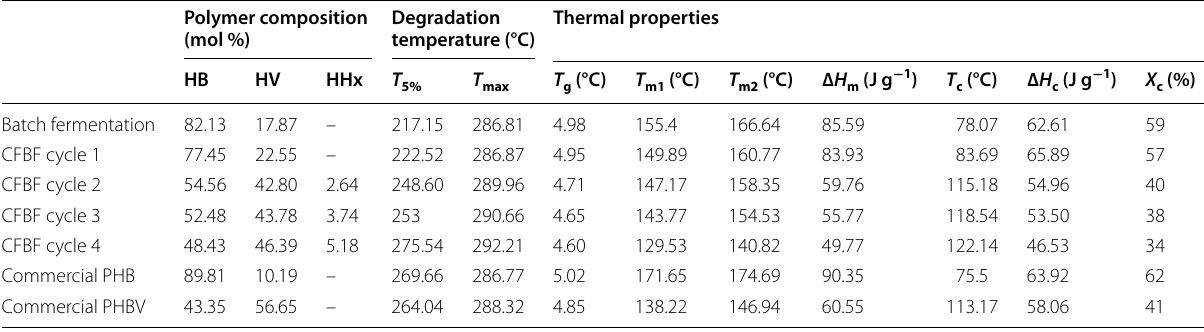
Table 5 Polymer composition, thermal properties, and thermal degradation of PHA extracted from B. thuringiensis after each cycle of the cyclic fed-batch fermentation compared with commercial PHB, and PHBV Polymer composition (mol